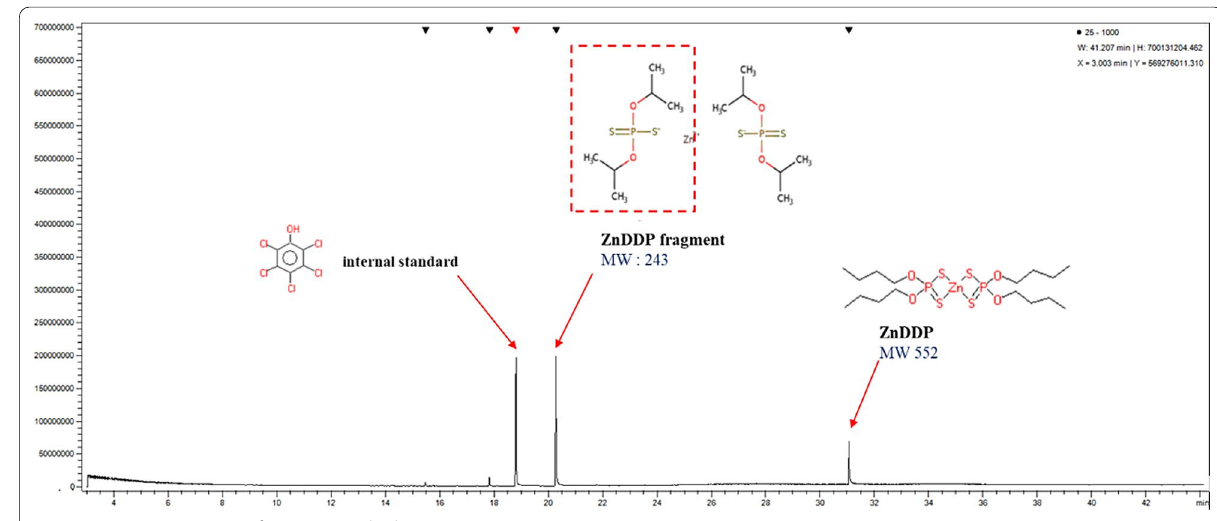
Fig. 2 TIC mass spectrum of ZnDDP standard